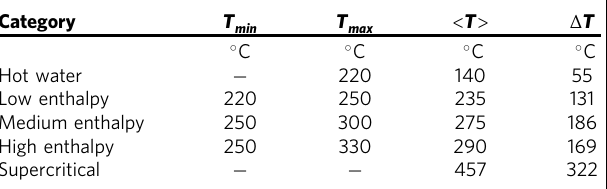
Table 1 Estimate of the injection temperature, obtained by extrapolation of values compiled in a literature review of several geothermal wells 62 . The linear extrapolation from literature values (with the estimated average temperature of Low Enthalpy systems of 140 (cid:1) C ) leads to the value of Δ T ¼ 322 (cid:1) C for the SC case